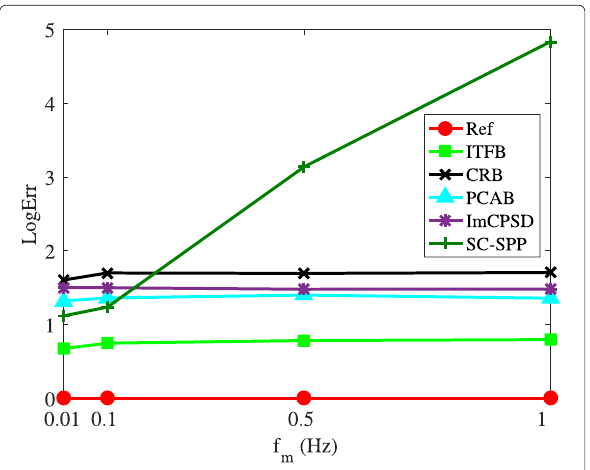
Fig. 7 Comparison of LogErr according to (46) averaged over all frame indices and frequency bins with different noise types and input SNRs, where θ = − 90